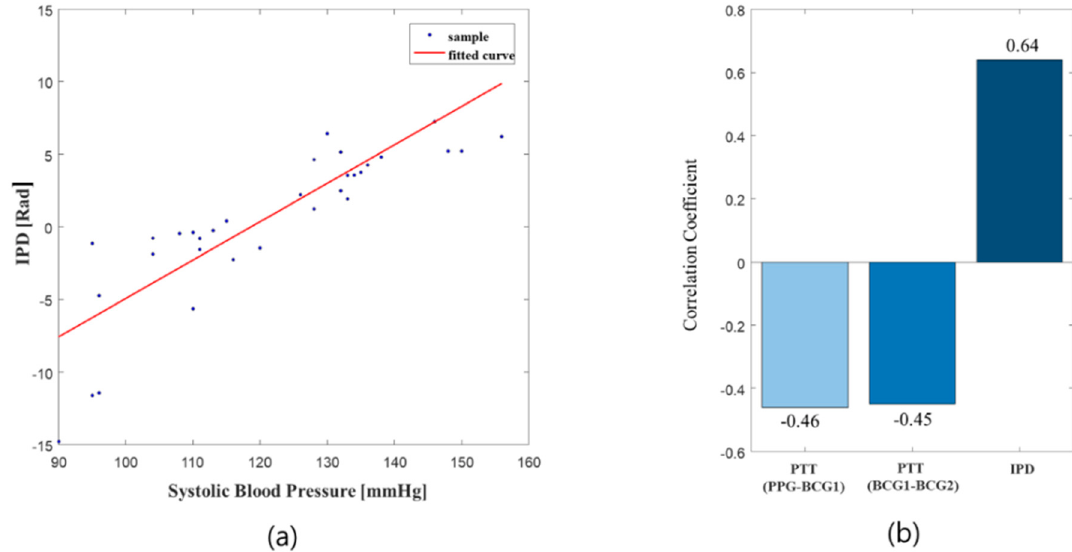
Figure 5. Relationships between systolic blood pressure and PTT/IPD, ( a ) systolic blood pressure and IPD, ( b ) correlation coefficient of systolic blood pressure with PTT/IPD.